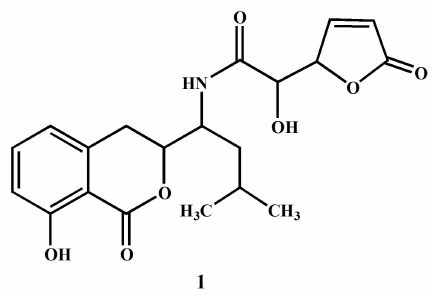
Figure 2. Nuclear magnetic resonance spectroscopic analysis of compound 1 (( S )-2-hydroxy- N - (( S )-1-(( S )-8-hydroxy-1-oxoisochroman-3-yl)-3-methylbutyl)-2-(( S